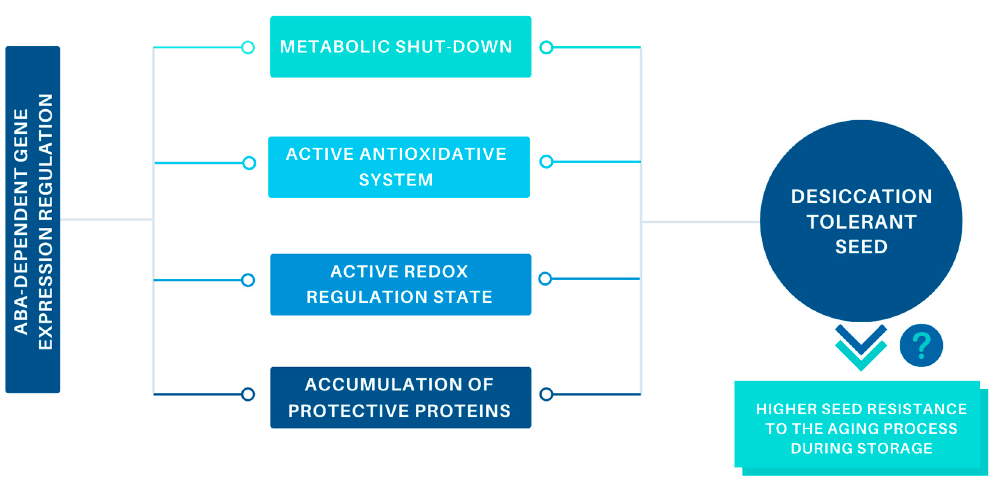
Figure 2. Simplified schema showing what factors are necessary for the development of desiccation tolerance in seeds. During seed maturation, abscisic acid (ABA)-dependent signaling a ff ects gene expression patterns, which lead to coordinated slowing of metabolism, activation of antioxidative and redox regulation systems, and accumulation of protective proteins. The acquisition of desiccation tolerance may contribute to higher seed resistance to the aging processes during long-term storage.